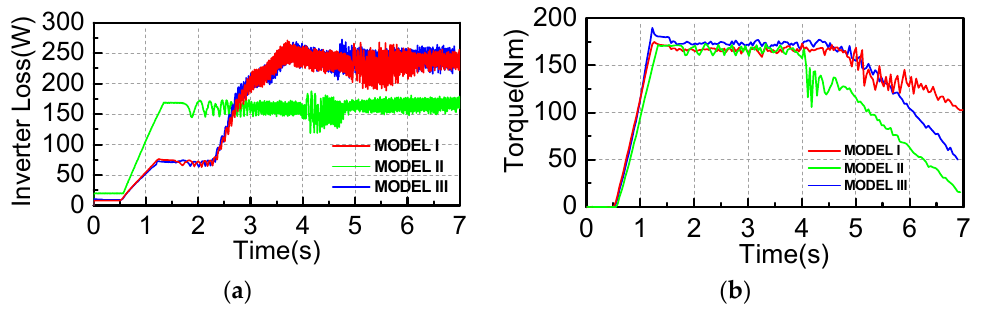
Figure 15. Simulation result the bus voltage when torque command is limited at 190 Nm. Energies 2017 , 10 , x FOR PEER REVIEW